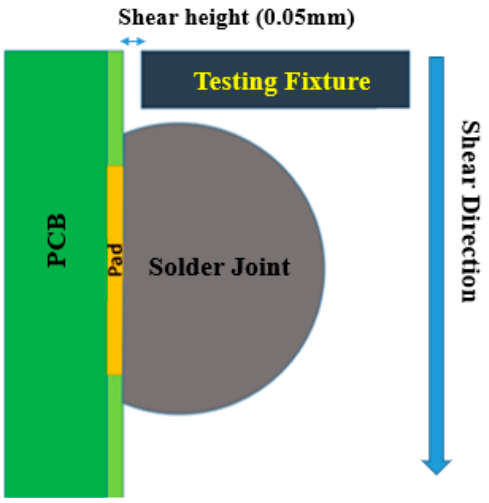
Figure 3. Shear testing schematic.